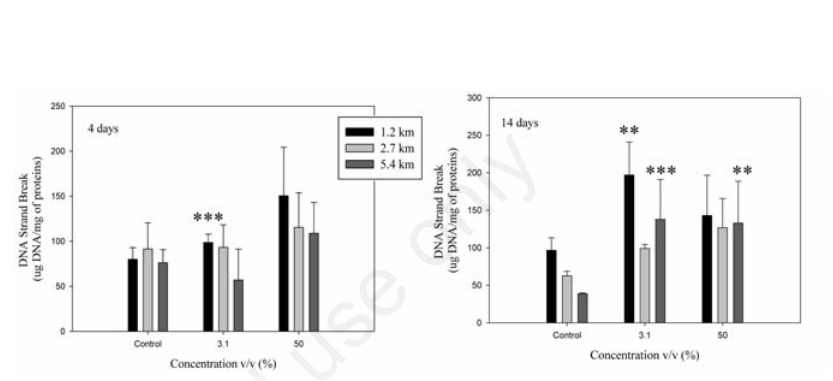
activity.Figure 4. Lipid peroxidation in trout liver after 4 and 14 days exposure to groundwater at 1.2 km, 2.7 km and 5.4 km. Data are presented as mean±standard error. No signifi- cant difference was observed (ANOVA P>0.05).